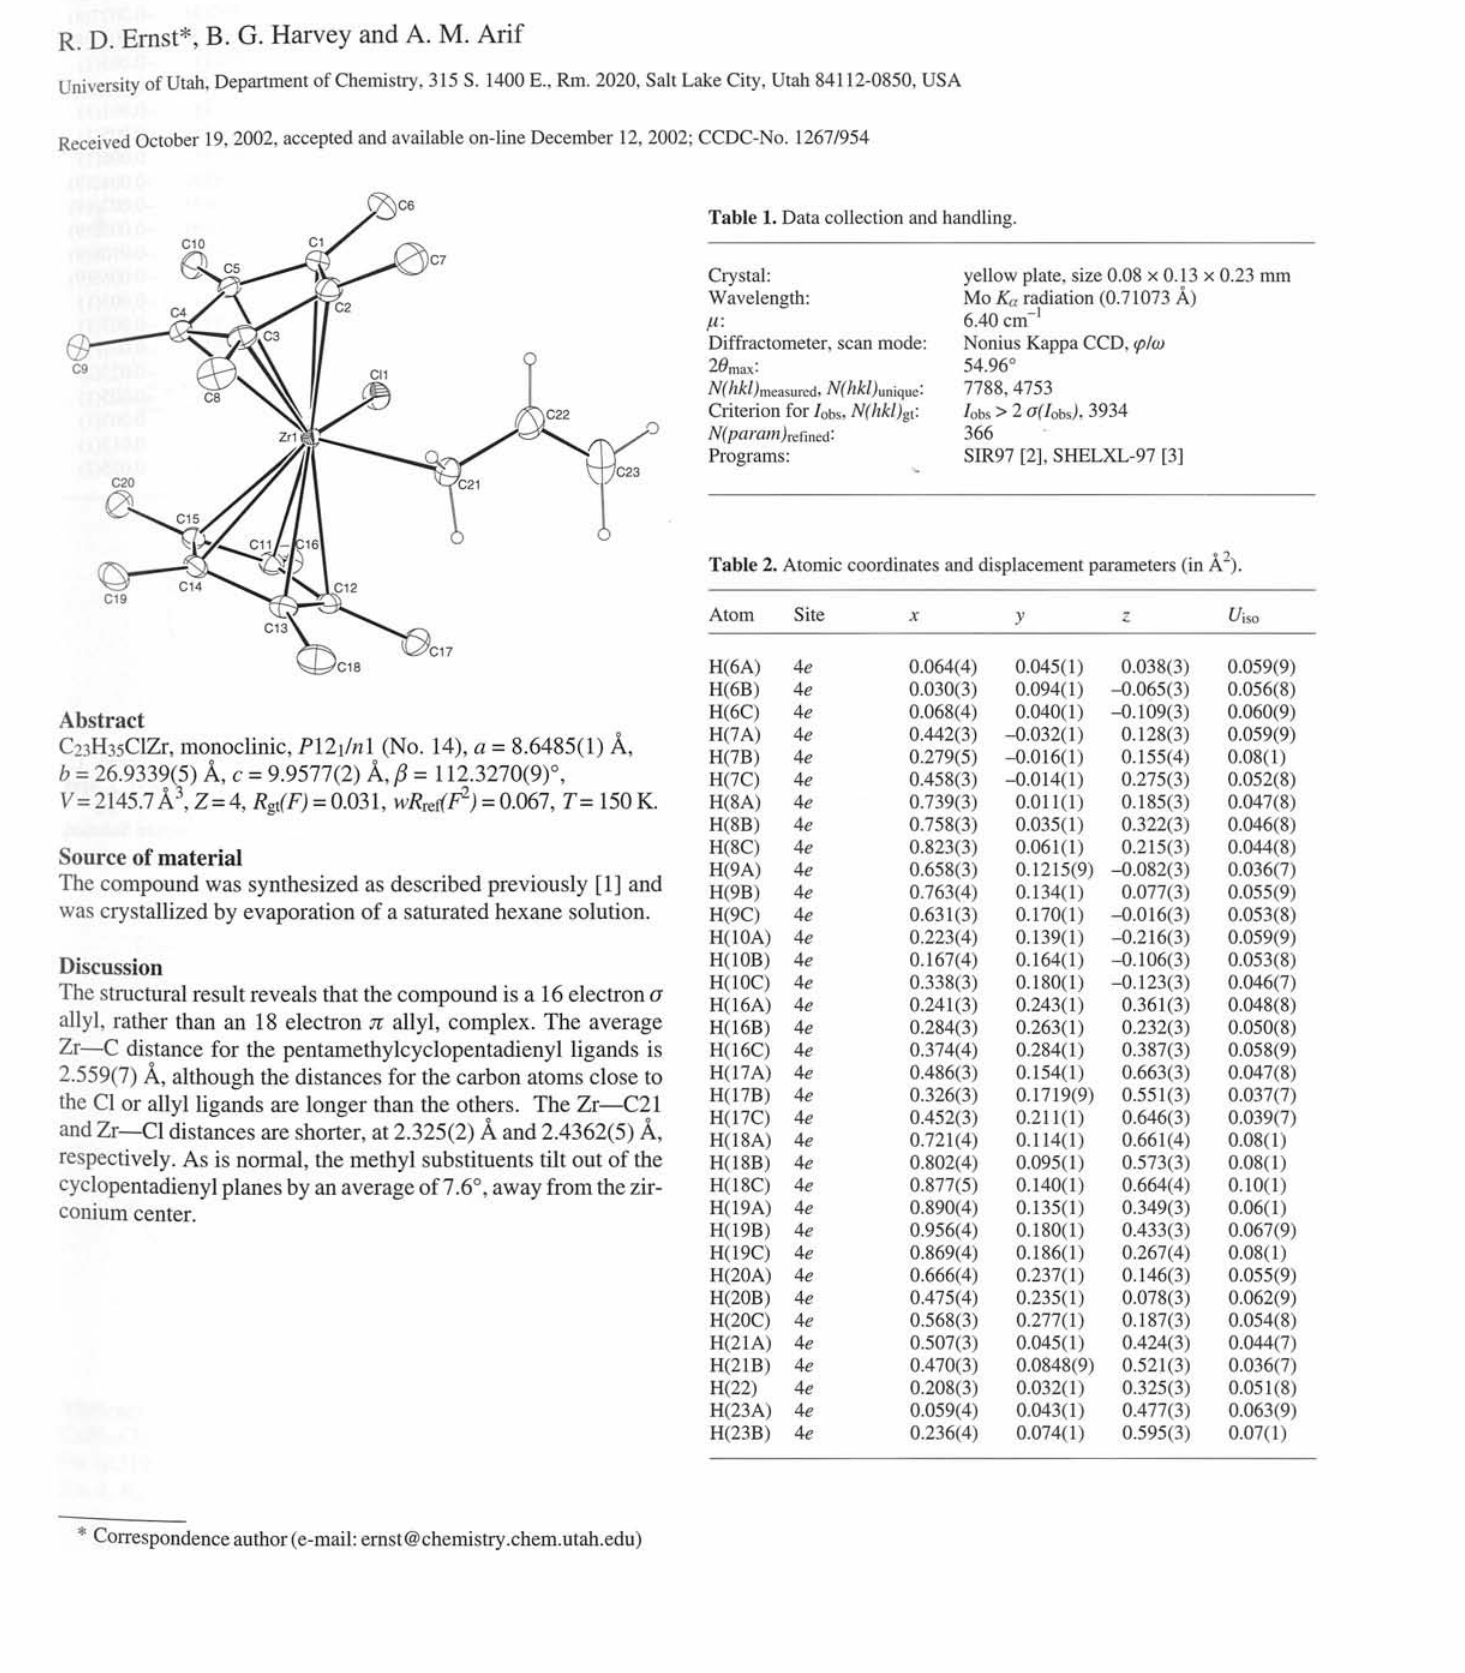
Table 1. Data collection and handling.